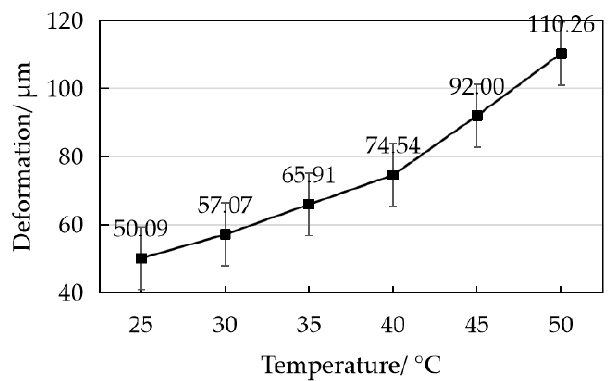
Figure 4. Simulation of coating deformation at different temperatures: ( a ) 25 °C; ( b ) 30 °C; ( c ) 35 °C; ( d ) 40 °C; ( e ) 45 °C; ( f ) 50 °C.